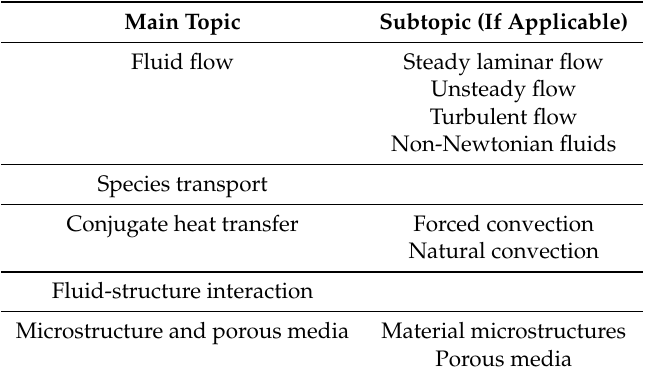
Table 3. Overview of flow topics treated in the review